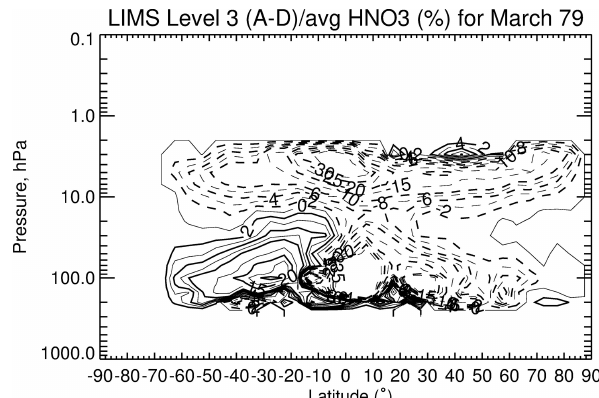
Figure 12. LIMS V6 level 3 ascending minus descending ( A − D ) HNO 3 differences divided by average HNO 3 (and given in %) for March 1979. CI is 2% from 0 to 10 and then 5% from 10 to 35; solid contours show positive